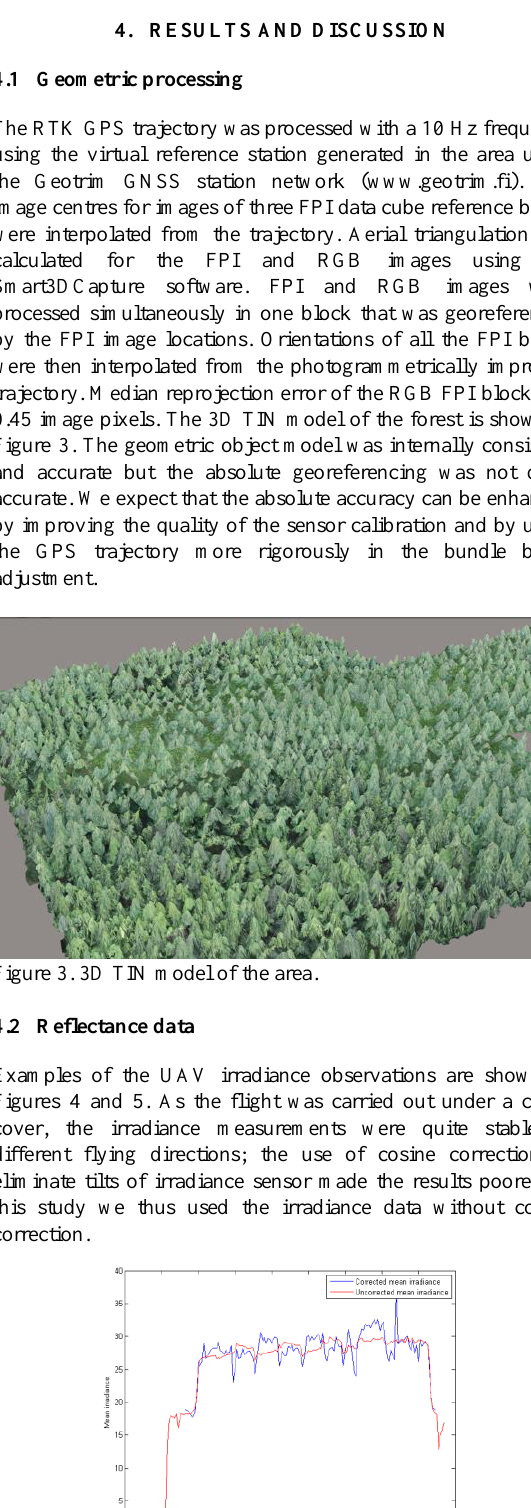
Figure 6. An example of reflectance measurement on a tree top. a) RGB and FPI image ( l0 =764 nm). b) Tree top radiance spectrum and the irradiance spectrum during the exposure. c) Reflectance of the tree top; tree: full spectra; tree-edited: without the problematic observation at l0 =764